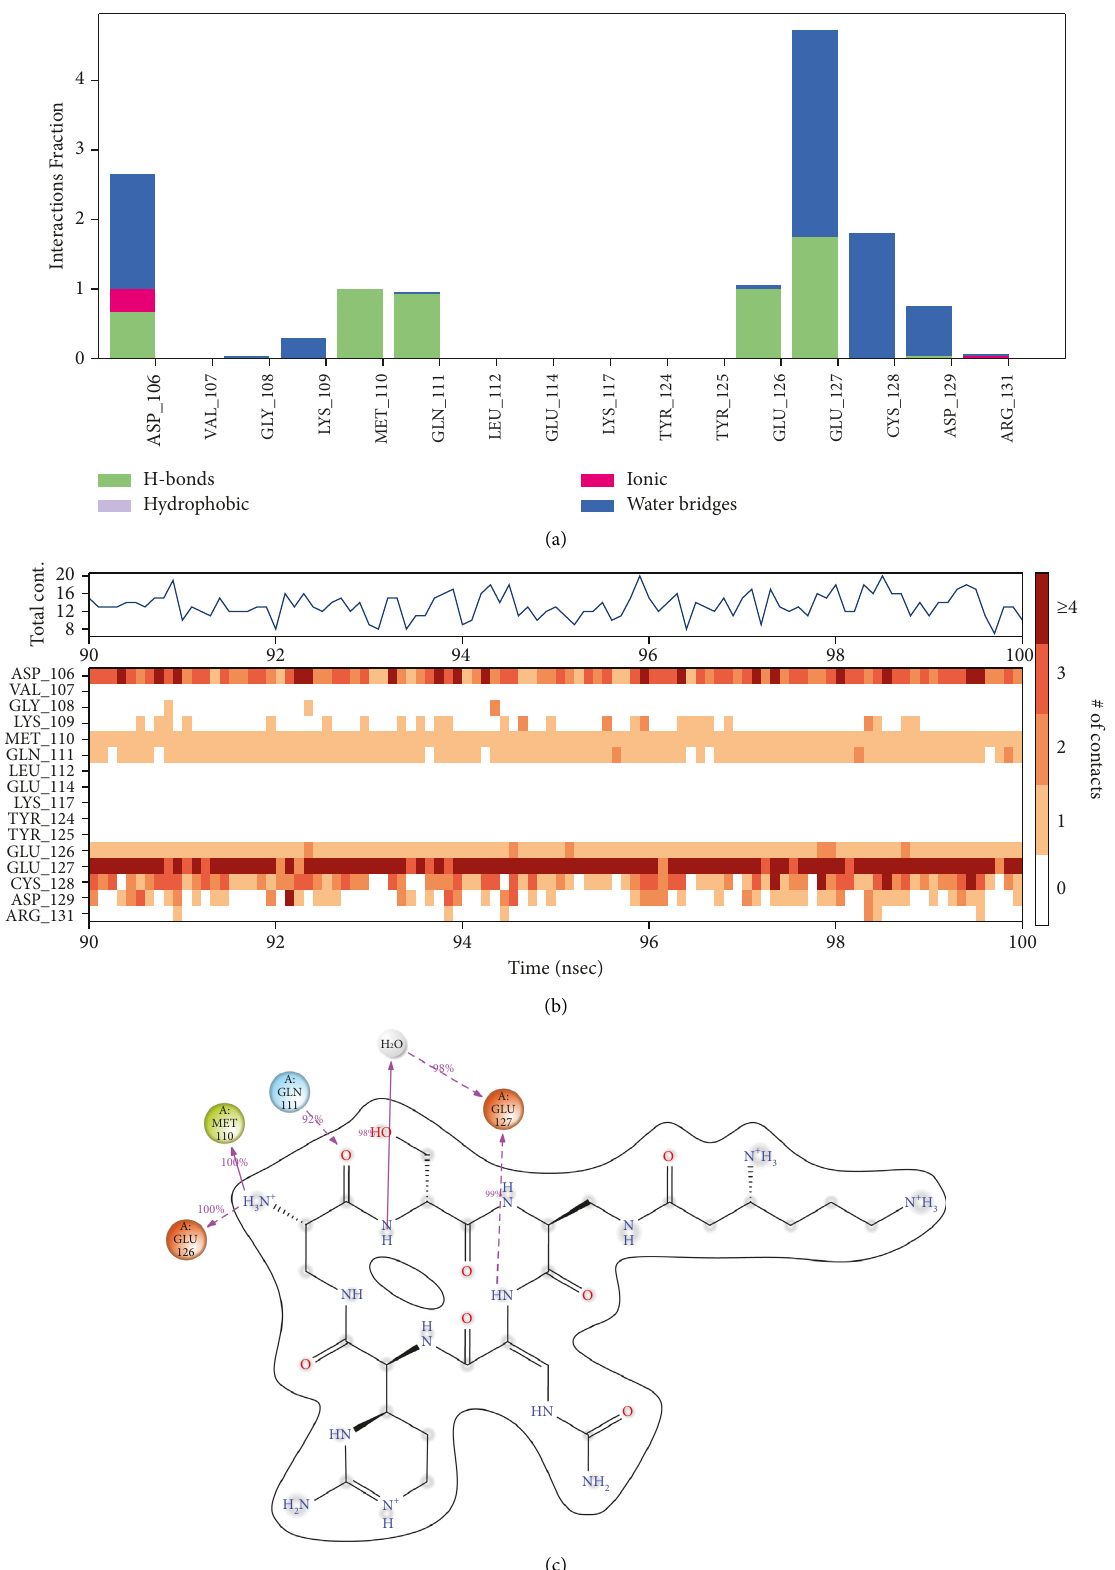
Figure 6: Protein-ligand contacts. (a) Histogram of protein-ligand contacts categorized by type of interactions: hydrogen bonds (green), hydrophobic interactions (purple), ionic bonds (magenta), and water bridges (blue). (b) Timeline representation of the interactions throughout 90–100ns. (c) A schematic representation of the detailed interactions of the ligand atoms with the protein